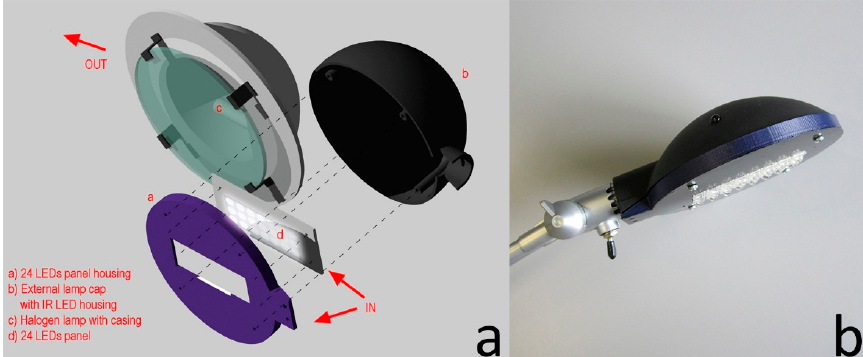
Figure 2. Smart Lamp: ( a ) assembly diagram of the lamp housing; ( b ) as installed.